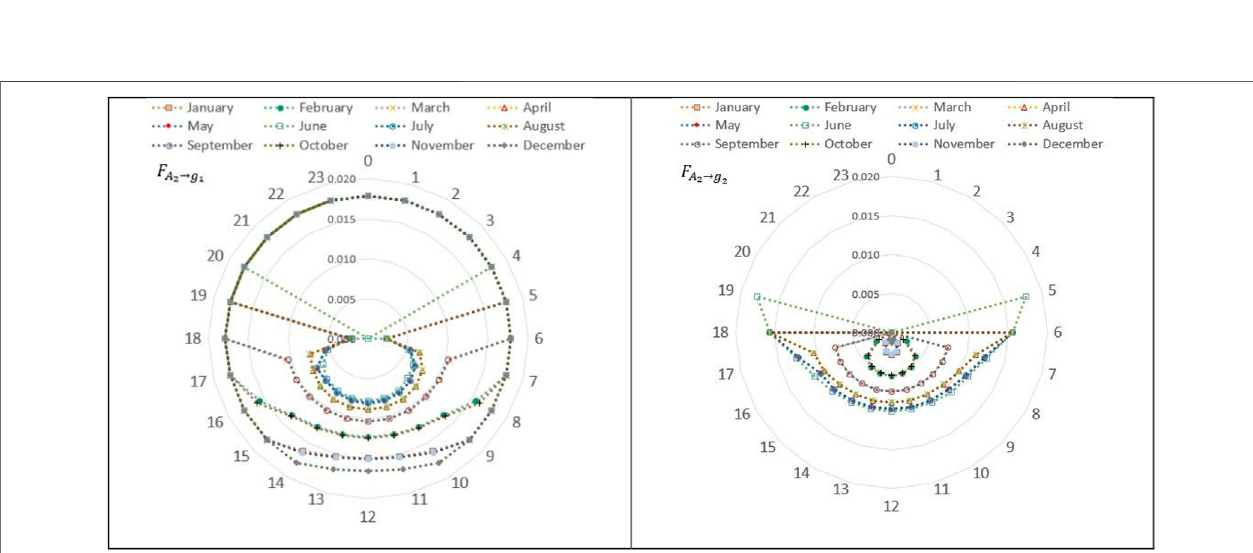
FIGURE 15 | Radar chart representing F A